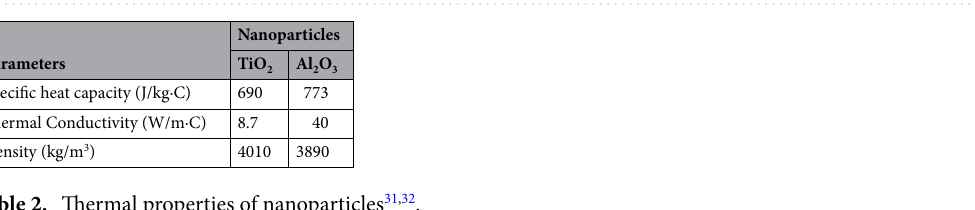
Table 2. Thermal properties of nanoparticles 31,32